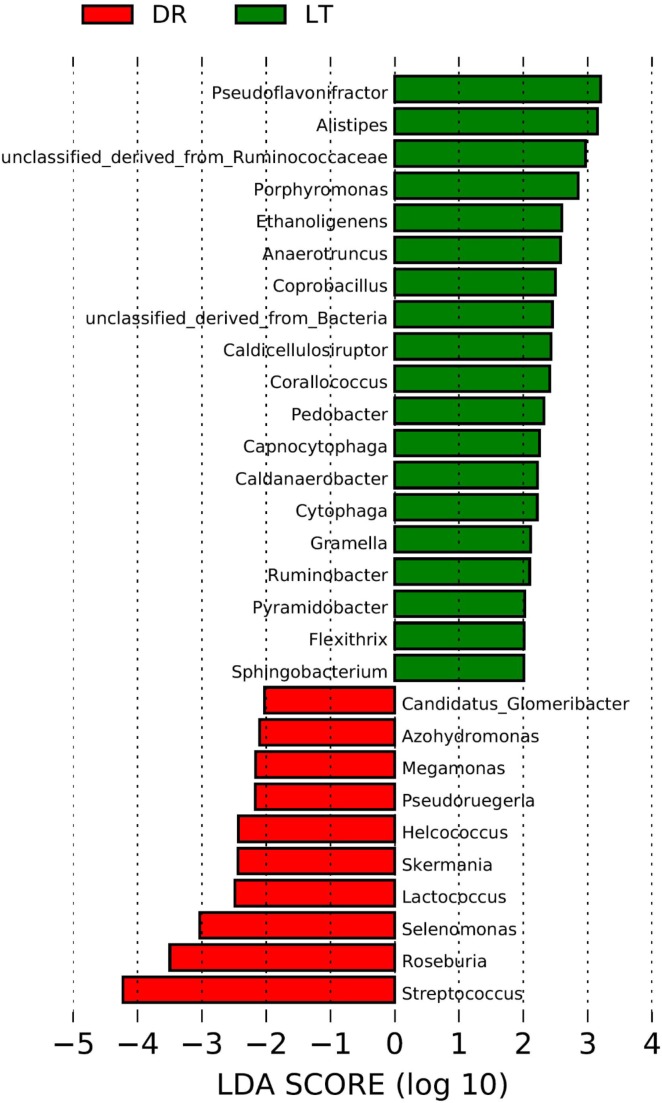
Difference in genera abundance in the fecal bacterial community from two pig breeds using Lefse software. The data analysis was performance using the Lefse software. Taxa enriched in the Drouc group (DR) are indicated with a negative LDA score (Red), and taxa enriched in the Lantang group (LT) have a positive score (Green). Only taxa meeting an LDA significant threshold of 2 are shown.